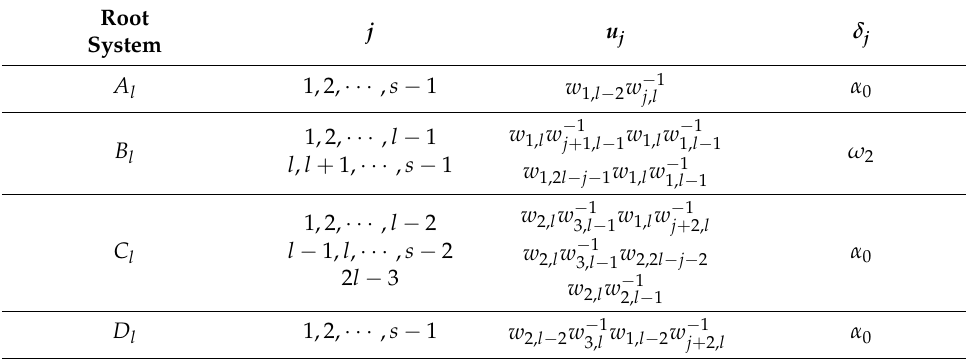
Table 3. Descriptions of u j and δ j . Root System